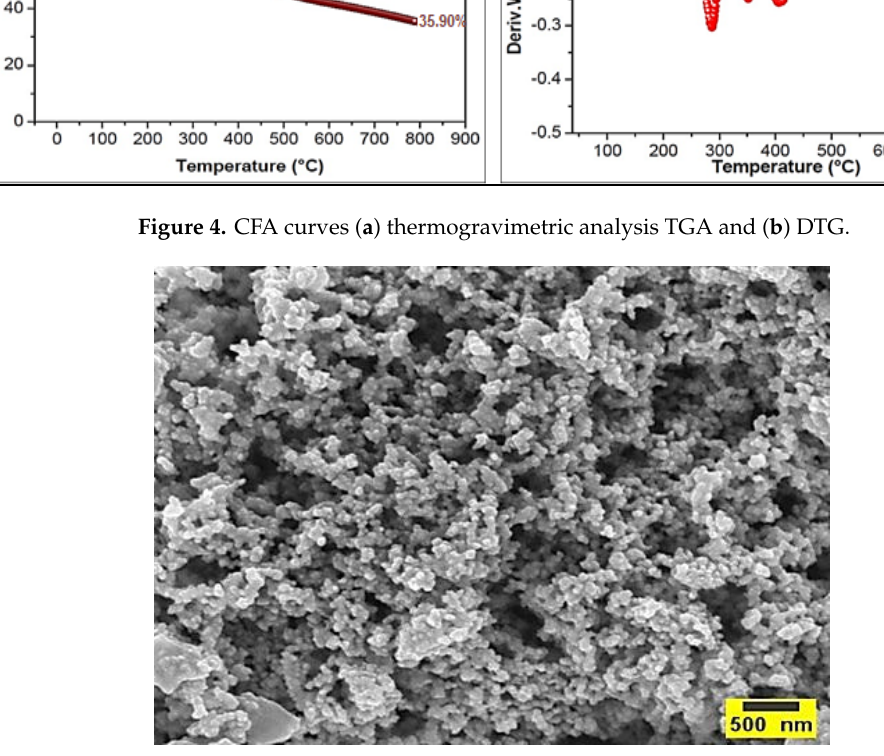
Figure 6. HRTEM micrograph of MgAl 2 O 4 NPs.